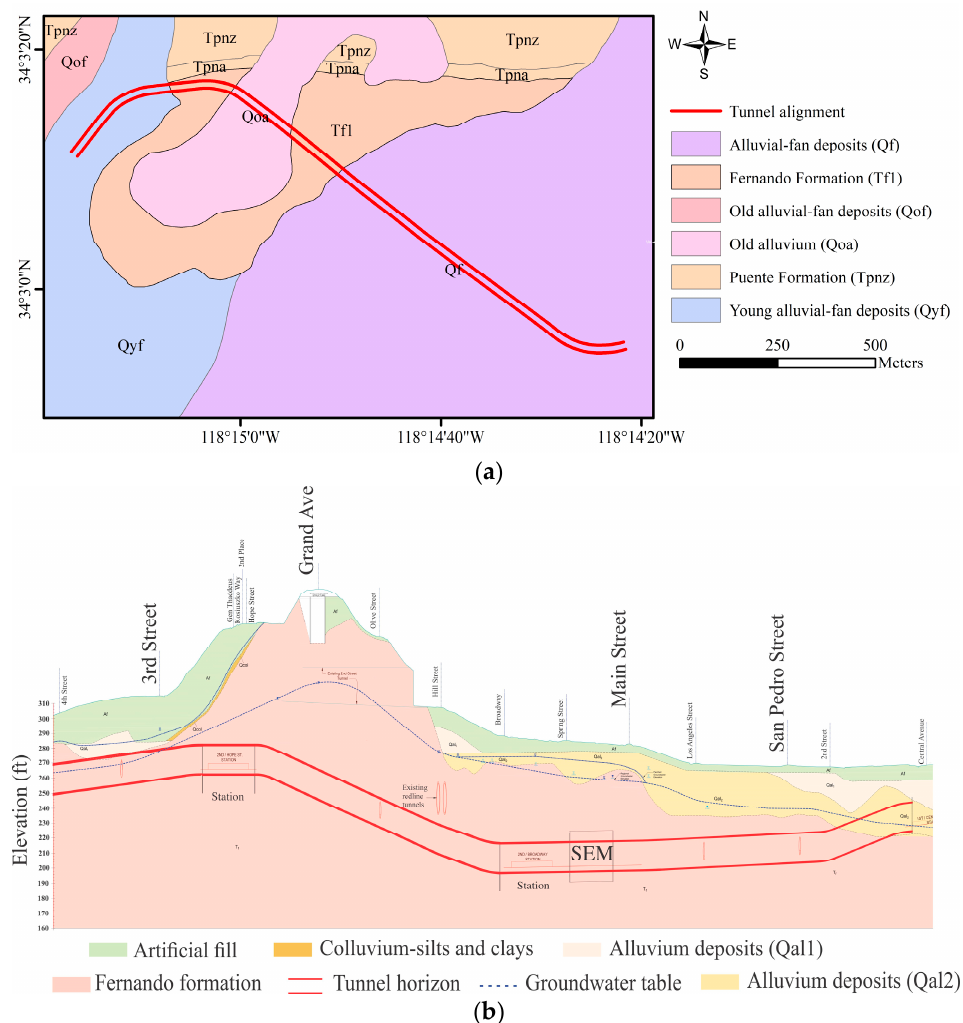
Figure 2. ( a ) A preliminary geologic map of the study area and ( b ) a geological section of twin ‐ bored tunnels. bored